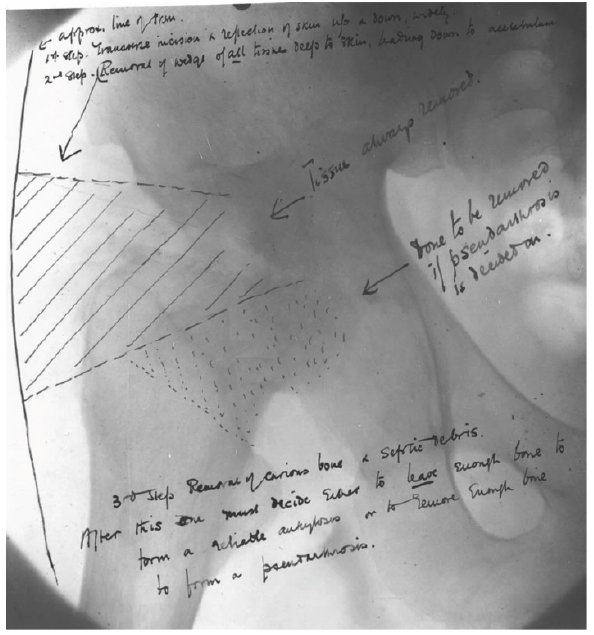
In the context of cerebral